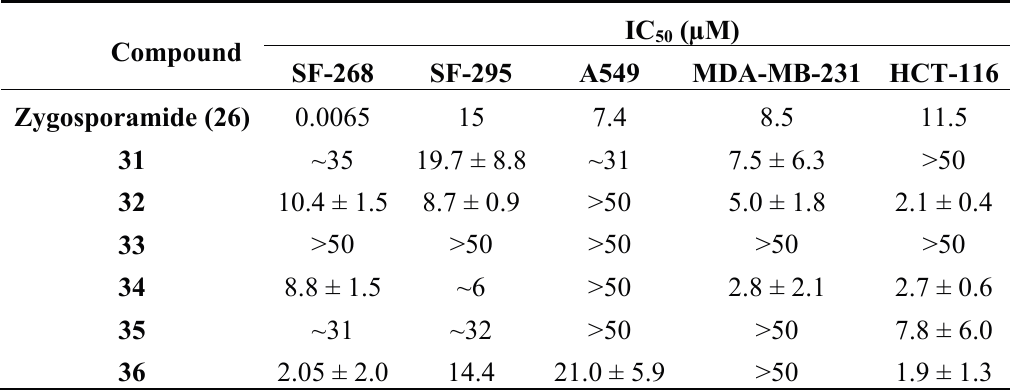
Table 1. Biological activities of zygosporamide